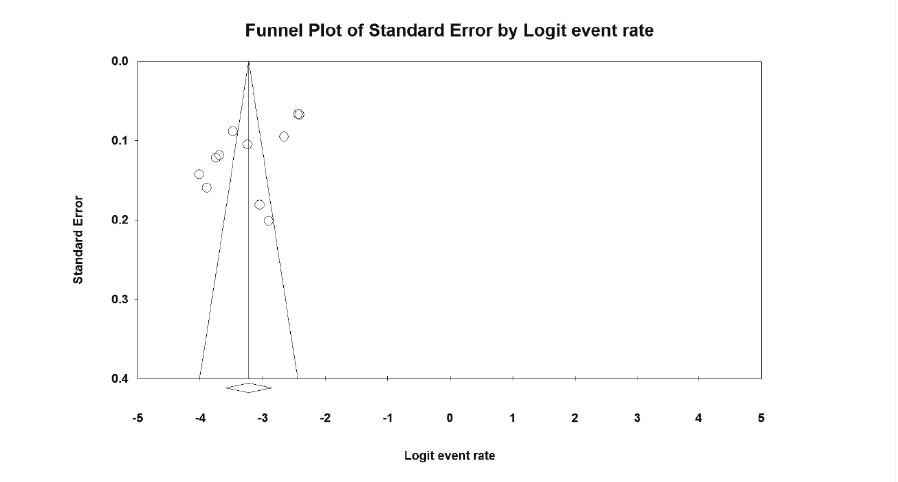
Figure 10. (Funnel plot) The results of the prevalence of color blindness in Iranian